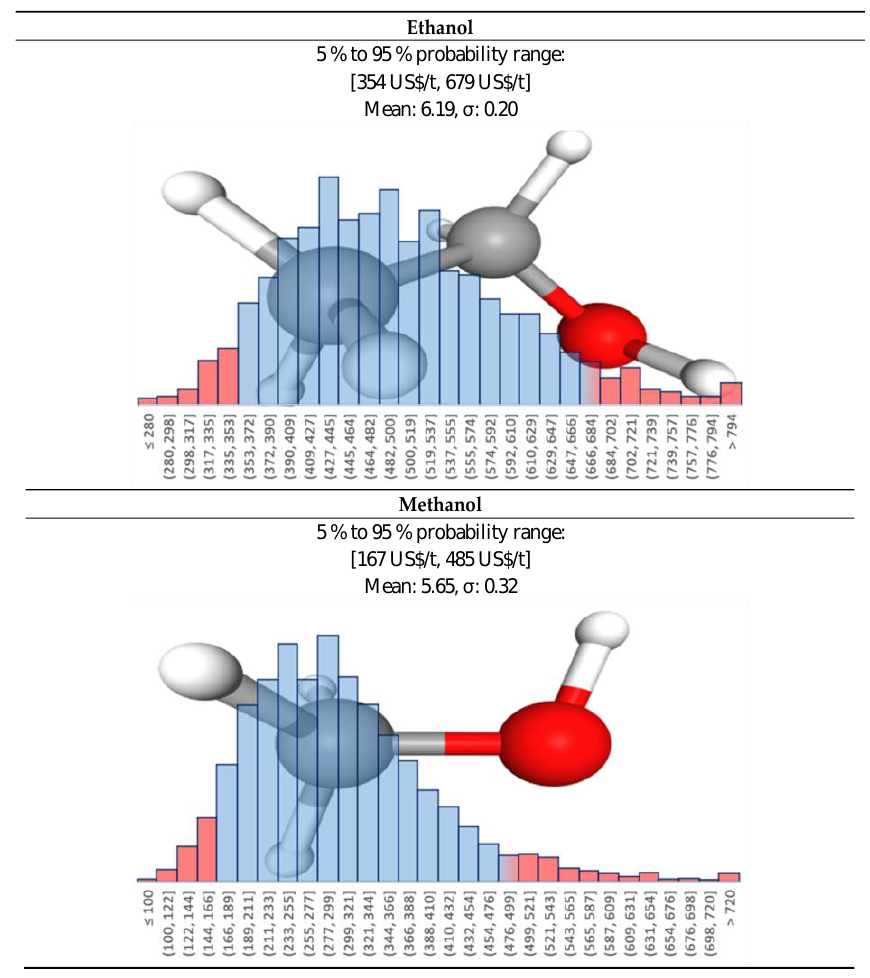
Figure 10. Ethanol [77] and sugar [76] prices in the US market between 2007 and 2020.